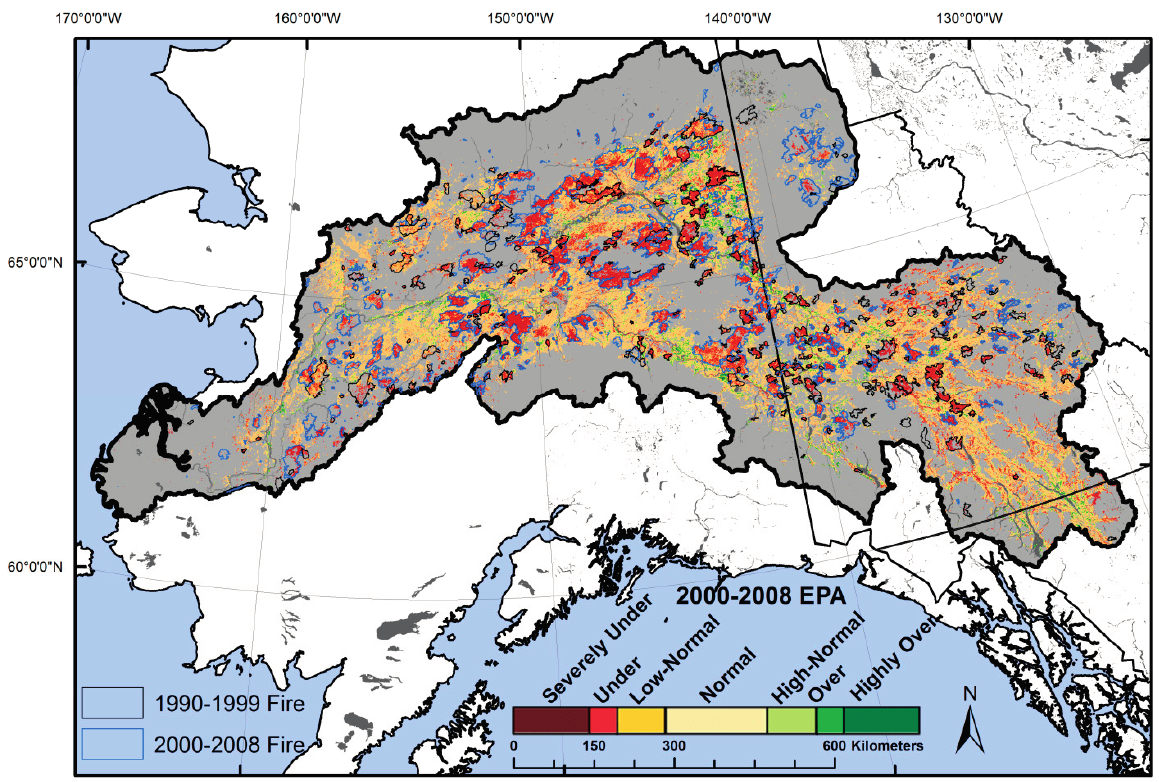
Figure 2. Years 2000 to 2008 average Ecosystem Performance Anomaly (EPA) for the Yukon River Basin boreal forest. 1990–1999 fires are outlined by grey, while 2000–2008 fires are outlined by